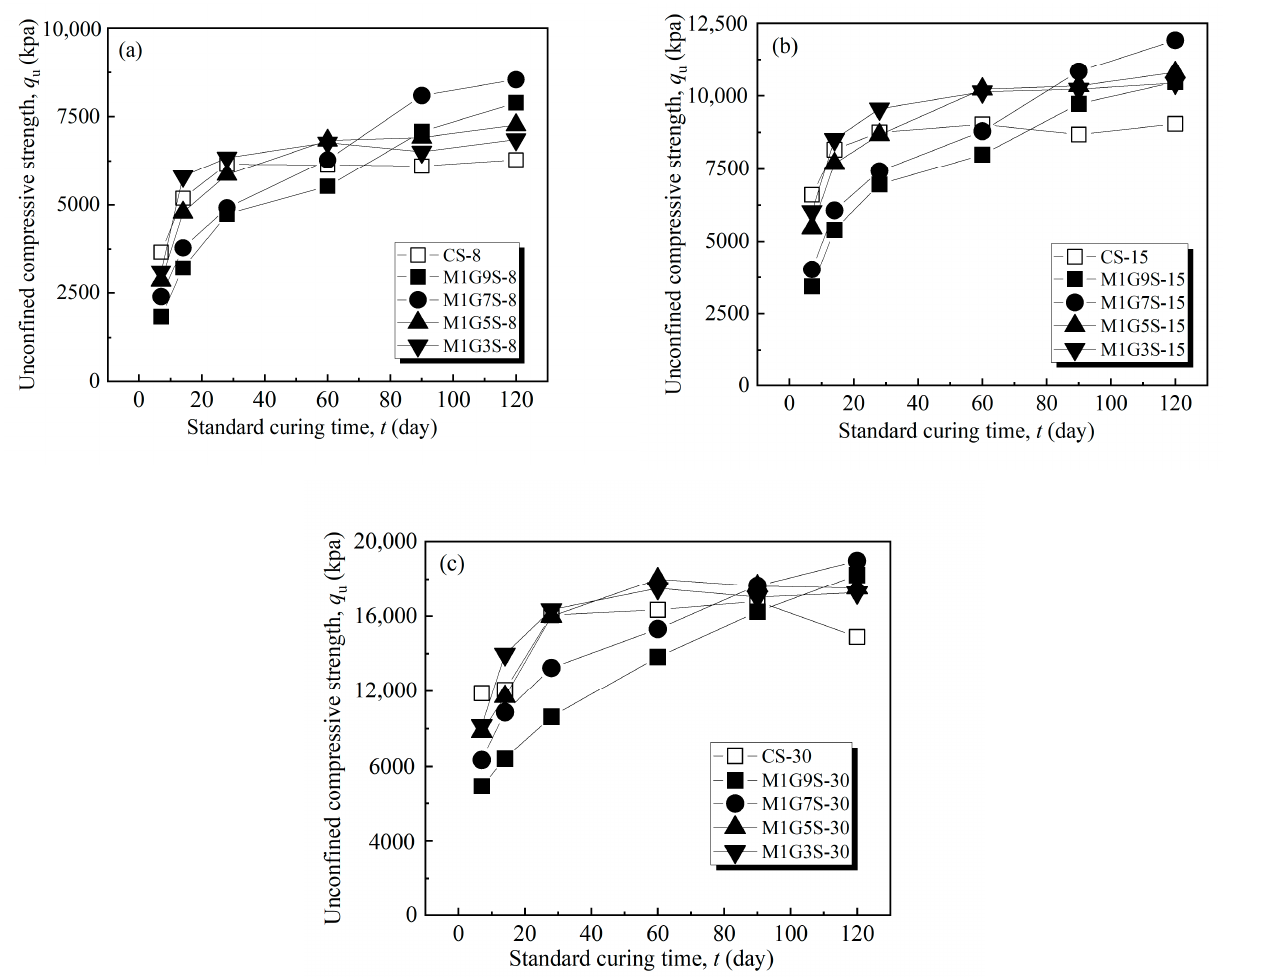
Figure 5. Variations of unconfined compressive strength ( q u ) with different ratios of binder on ( a ) 8%, ( b ) 15%, and ( c ) 30%.